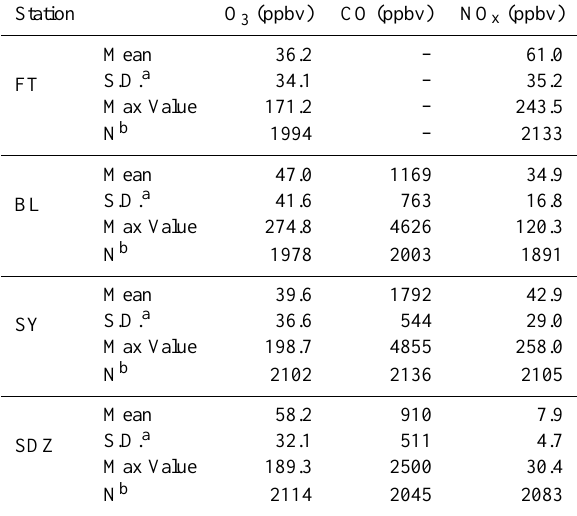
Table 2. Statistical summary of hourly averaged concentrations of O 3 and its precursors for each